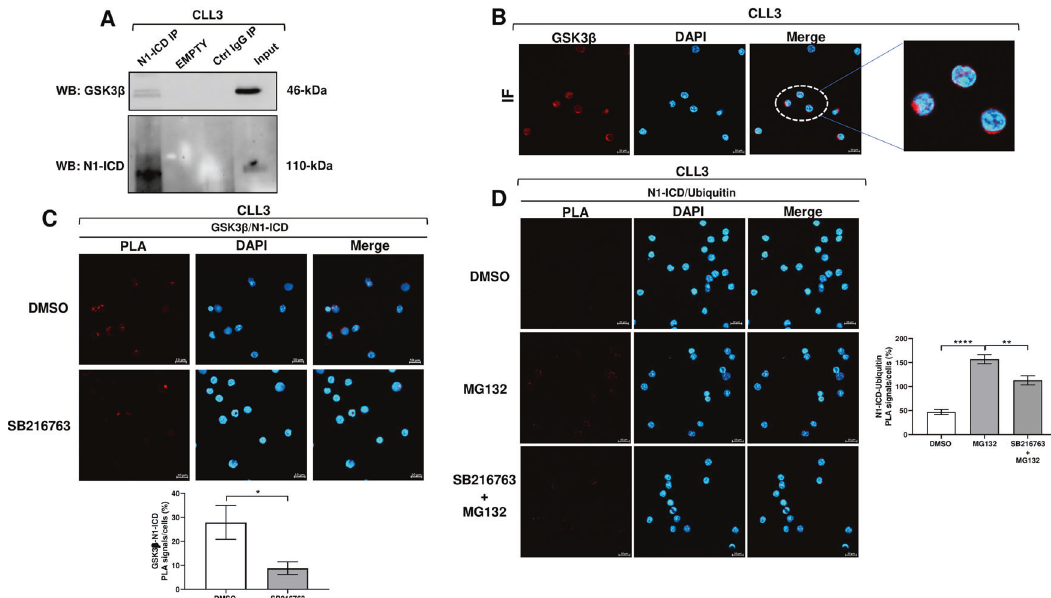
Fig. 3 GSK3 β interacts with N1-ICD in CLL cells and is involved in N1-ICD ubiquitination. A N1-ICD was immunoprecipitated (IP) from whole-cell extracts of CLL cells, and the IP lysates were analyzed by Western blot with the anti-NOTCH1 (Val1744) to con fi rm IP of N1-ICD, and with the anti-GSK3 β antibody to detect GSK3 β /N1-ICD interaction ( n = 3). One representative CLL is shown. B Confocal microscopy images of subcellular localization of GSK3 β in a representative CLL sample. CLL cells ( n = 3) were stained with the anti-GSK3 β antibody (red) and with DAPI for nuclei (blue) and then analyzed by confocal microscopy, with a 63x oil immersion and 1.4 NA objective; scale bar, 10 μ m. C , D PLA was performed by using rabbit anti-NOTCH1 (Val1744) and mouse anti-GSK3 β antibodies to detect GSK3 β /N1-ICD interactions in CLL cells cultured for 1.5 h with 5 µM SB216763 or DMSO ( C ; n = 3), and by using rabbit anti-NOTCH1 (Val1744) and mouse anti-ubiquitin antibodies to detect N1-ICD/Ubiquitin interactions in CLL cells cultured with 5 µM SB216763 or DMSO for 1.5 h, and with 10 µM MG132 for additional 4 h ( D ; n = 3). Nuclei were stained with DAPI. In the confocal microscopy images, red spots indicate GSK3 β /N1-ICD ( C ) and N1-ICD/Ubiquitin ( D ) interactions. Images were acquired by using confocal microscopy with a 63x oil immersion and 1.4 NA objective; scale bar, 10 μ m. One representative CLL is shown. In the bottom panel ( C ) and in the right panel ( D ), bar graphs ± SEM show quantitative analysis of the PLA signals of three samples. *** *P < 0.0001; * *P < 0.01; *P < 0.05 according to unpaired Student ’ s t-